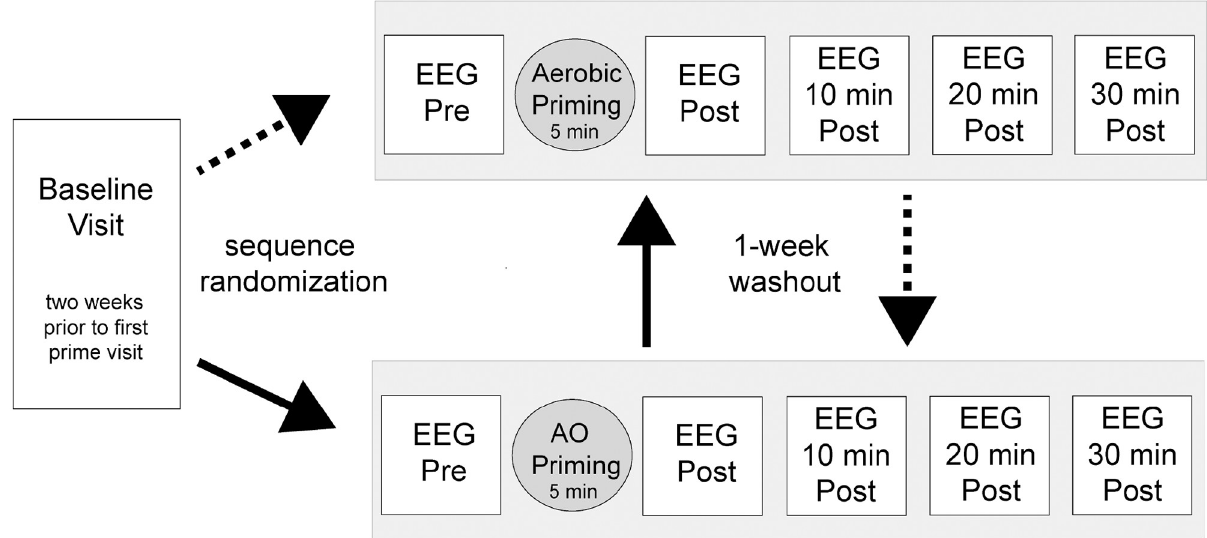
Fig 1. Experiment and study design. Participants completed one baseline visit and two priming visits (grey boxes) separated by a one-week washout period. Priming order was randomized to either aerobic exercise priming first and action observation priming second (dotted arrows) or action observation priming first followed by aerobic exercise priming a week later (solid arrows). During each priming visit, participants completed five three- minute resting-state electroencephalography recordings before, after, and at 10, 20, and 30 minutes following a 5-minute bout of priming.